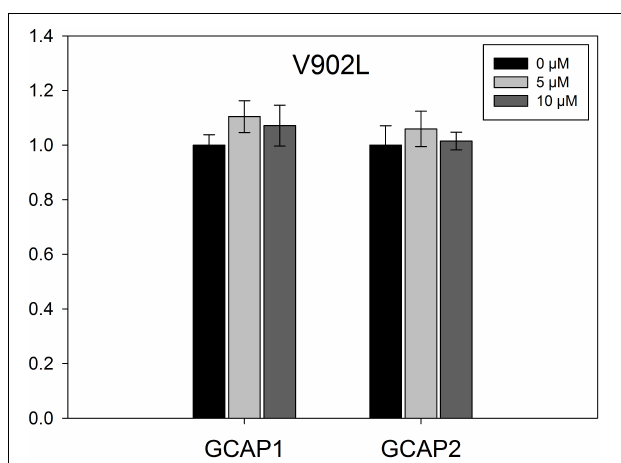
FIGURE 5 | EC 50 measurements for mutant V902L. The GC-E mutant V902L was incubated with increasing concentrations of GCAP1 or GCAP2 ranging from 0 to 10 µ M. GC-E activity was calculated via the amount of produced cGMP measured by HPLC. The GC-E activity at 0 µ M GCAP was set to 1. Each data point represents the mean value of three replicates with the standard deviation. The experiment was repeated with similar